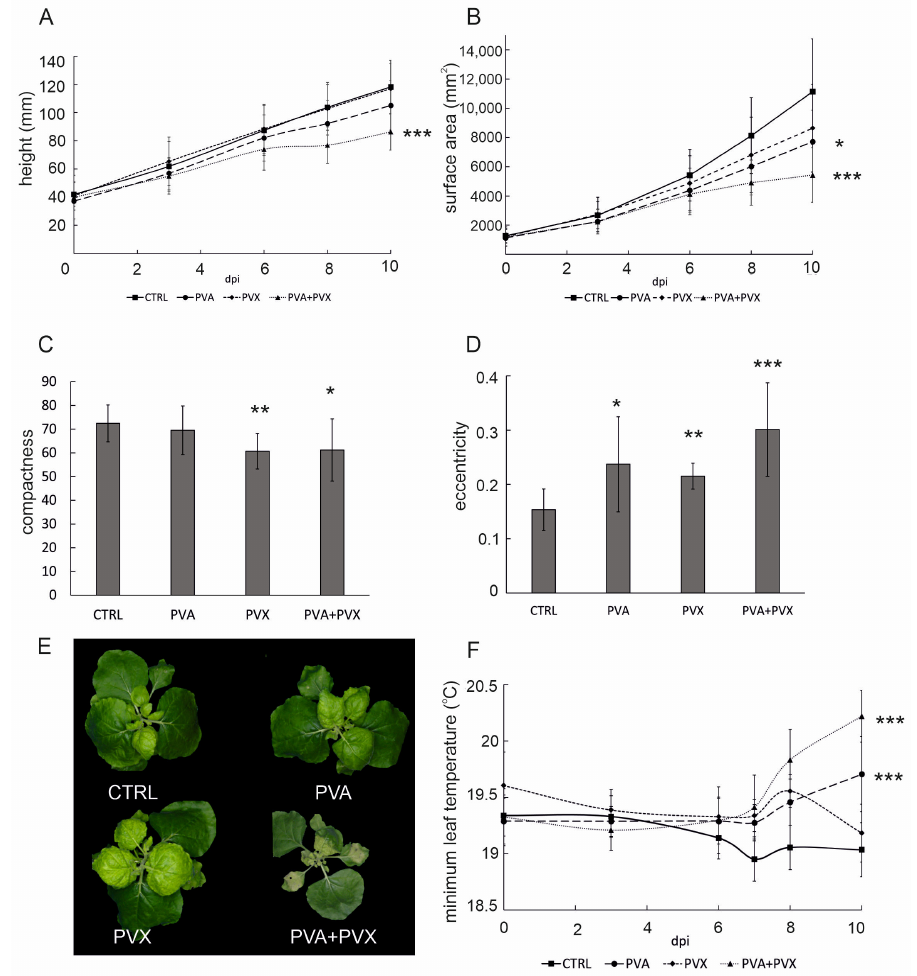
Figure 2. Image-based phenotyping results showing the effect of single and mixed PVA and PVX infections on ( A ) plant height, ( B ) surface area. Effects on plant morphology, i.e., ( C ) compactness and ( D ) eccentricity were calculated from image data at 10 dpi. ( E ) Representative RGB images of control, PVA, PVX and PVA + PVX -infected plants at 10 dpi. ( F ) Effect of single and mixed PVA and PVX infections on minimum leaf temperature. Plants were imaged with a thermal infrared camera. Results are presented as averages from one phenotyping experiment, error bars denote standard deviation and statistical significance was calculated by Student’s t -test (* p < 0.5, ** p < 0.01, *** p < 0.001).